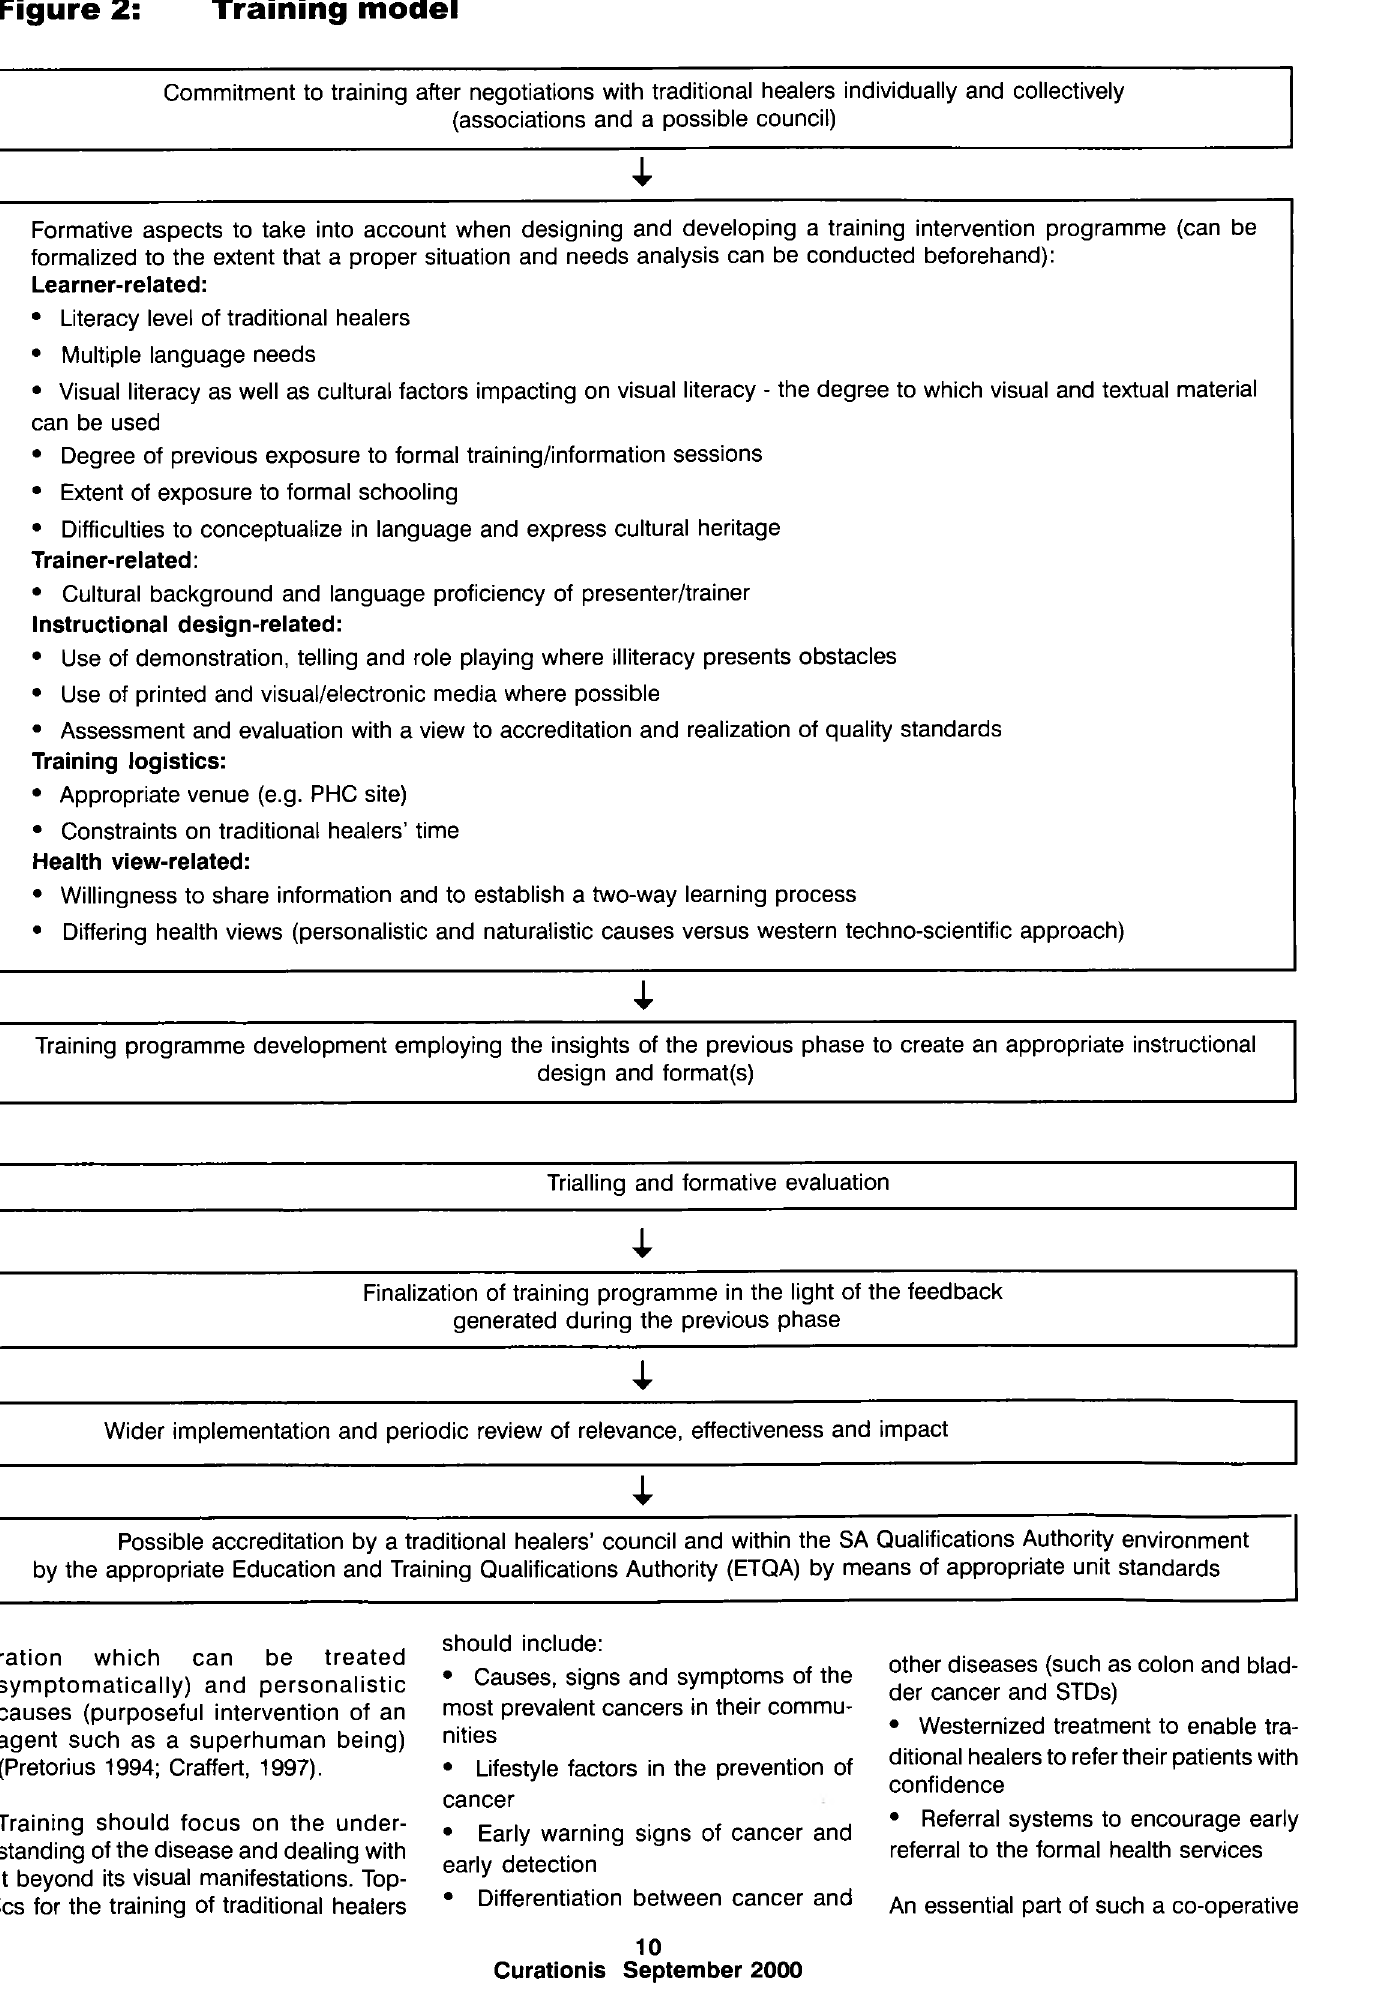
Figure 2: Training m odel Commitment to training after negotiations with traditional healers individually and collectively (associations and a possible